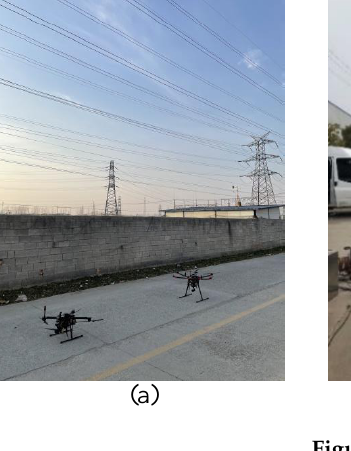
Figure 10. Actual flight environment. ( a ) Preparation stage of autonomous inspection operation of UAV; ( b ) Intelligent machine nest test; ( c ) Single UAV for autonomous inspection operation; ( d ) Multiple UAVs for autonomous inspection operations.